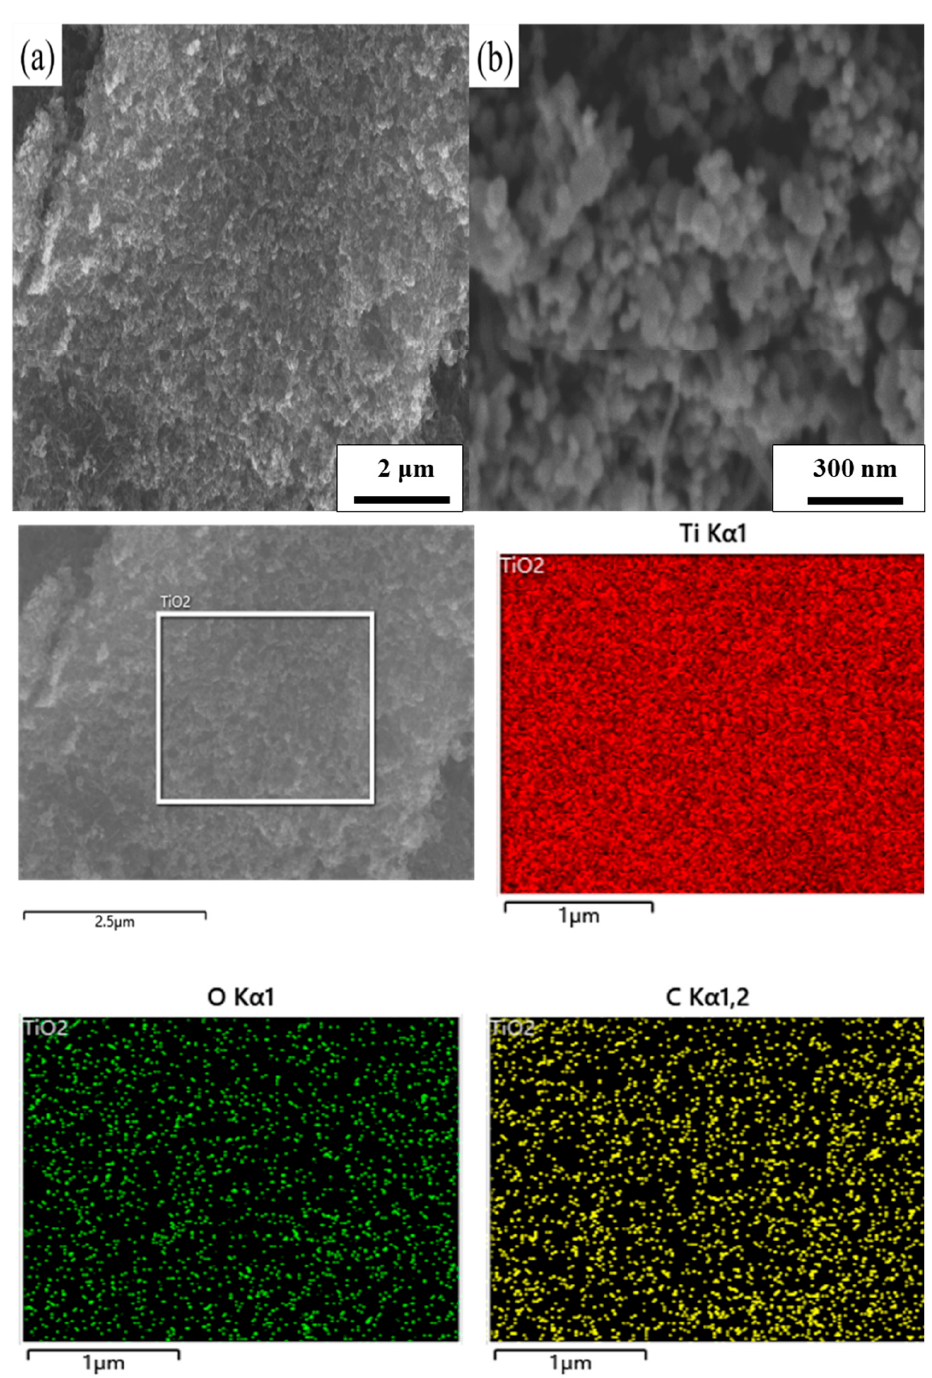
Figure 2. EDS mapping of TiO 2 /CNT/CQD: ( a ) and ( b ) are SEM images of the TiO 2 /CNT/CQD mesoporous composite.